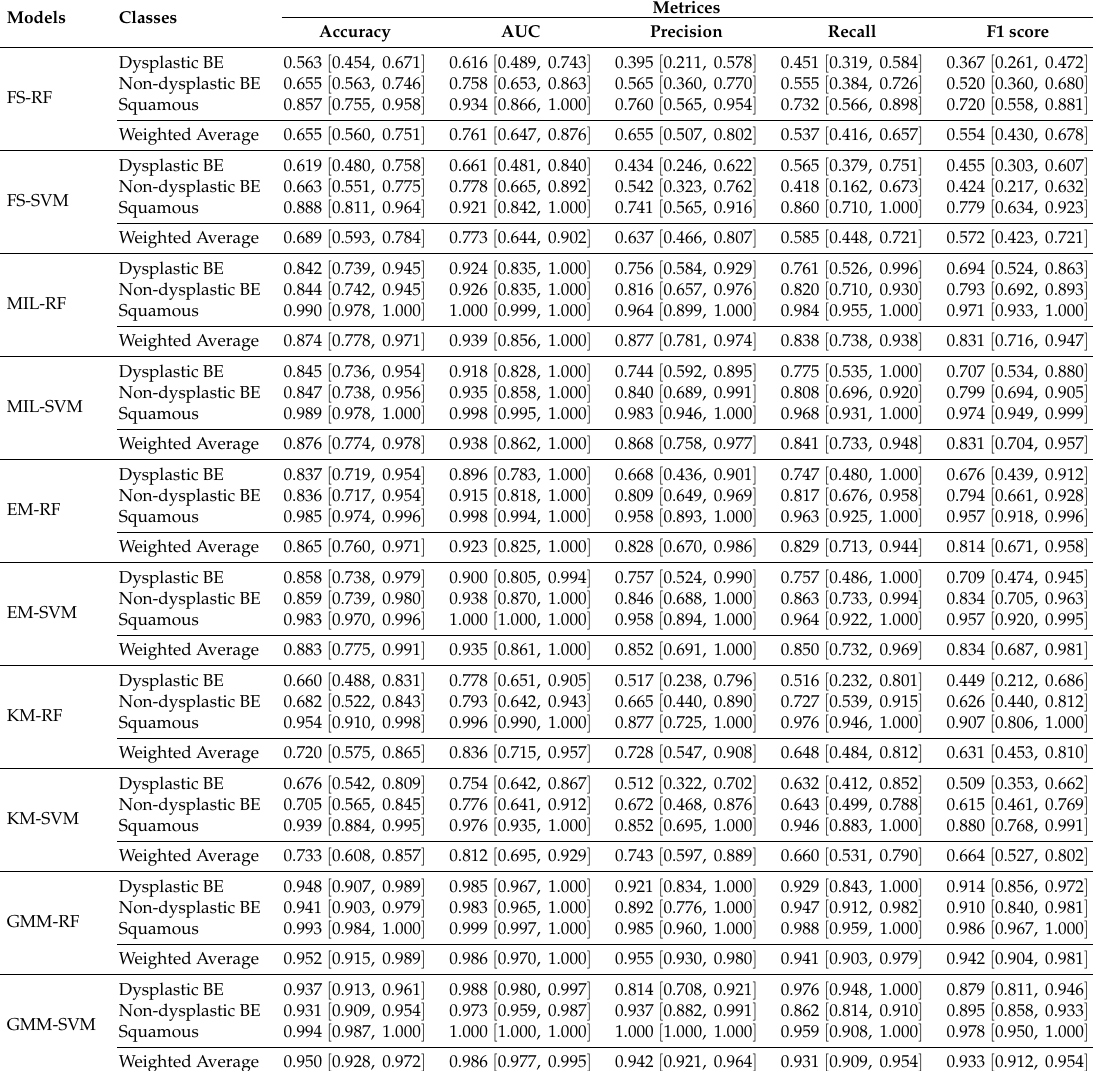
Table 2. Results of WSI classification.